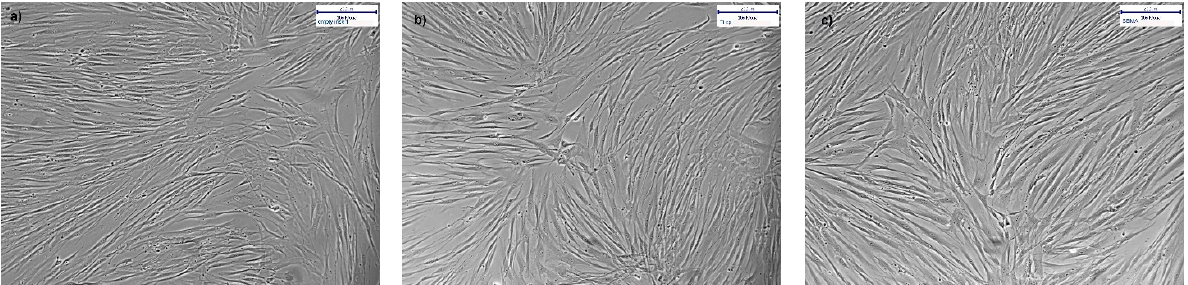
Figure 6. ( a – c ): 72 h hgF culture in indirect contact with a Thermanox cover slip ( a ), TiCP ( b ), and polySBMA-coated TiCP ( c ).